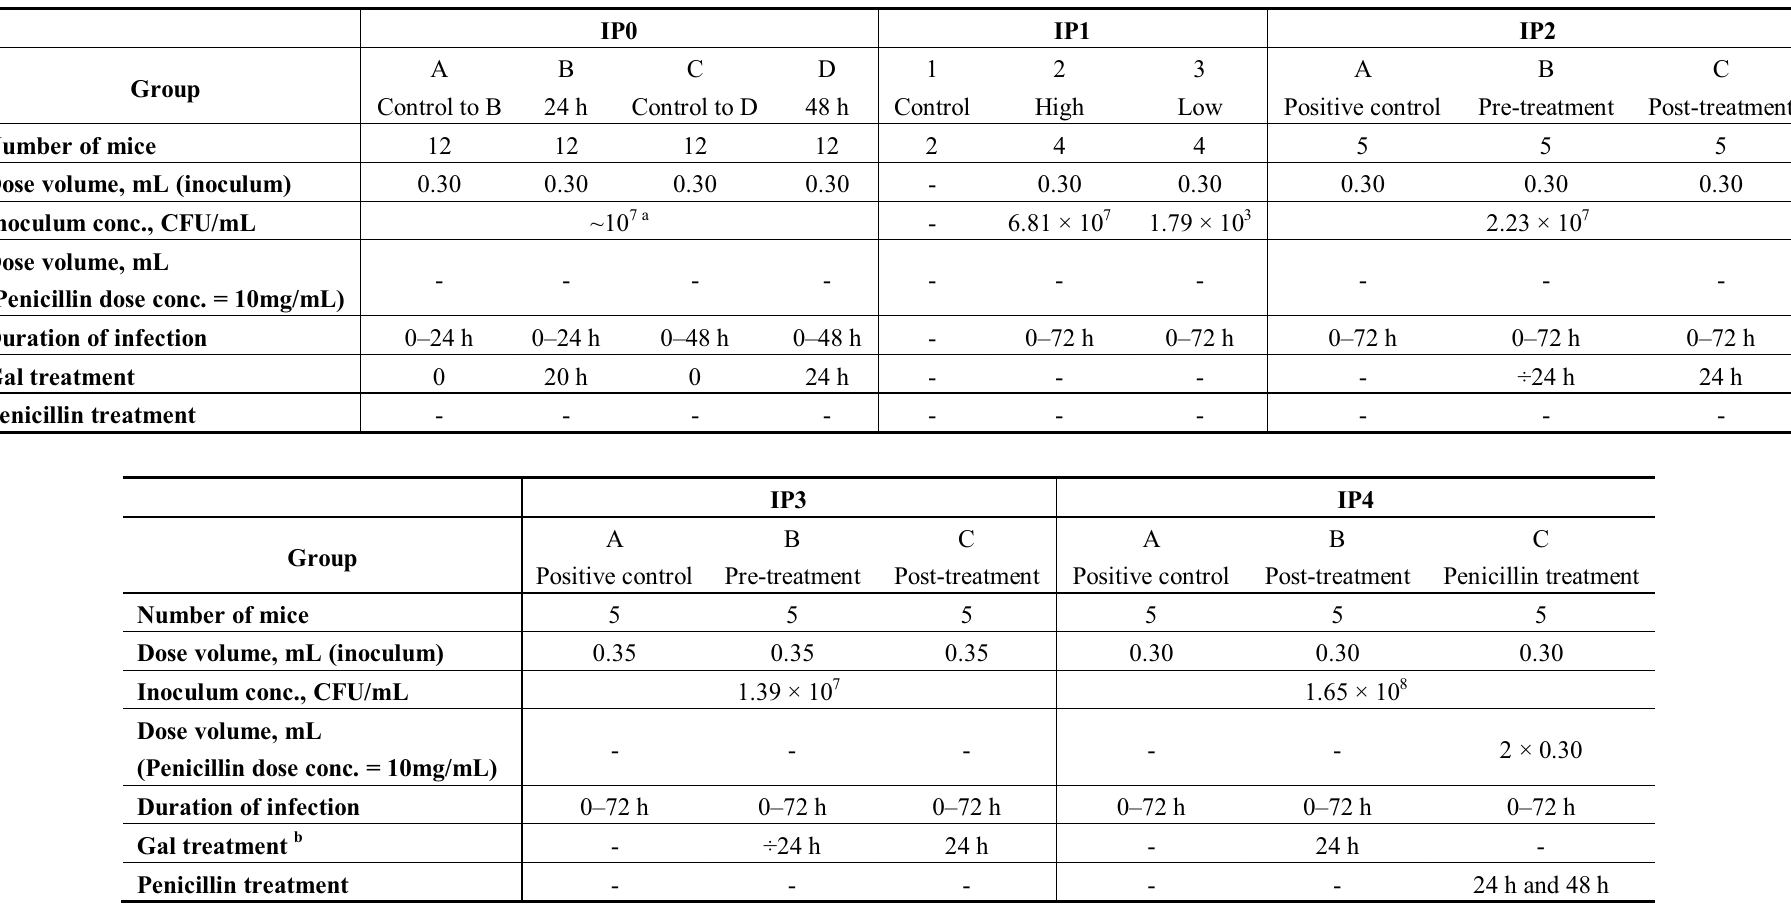
Table 1. Overview of Mouse experiments